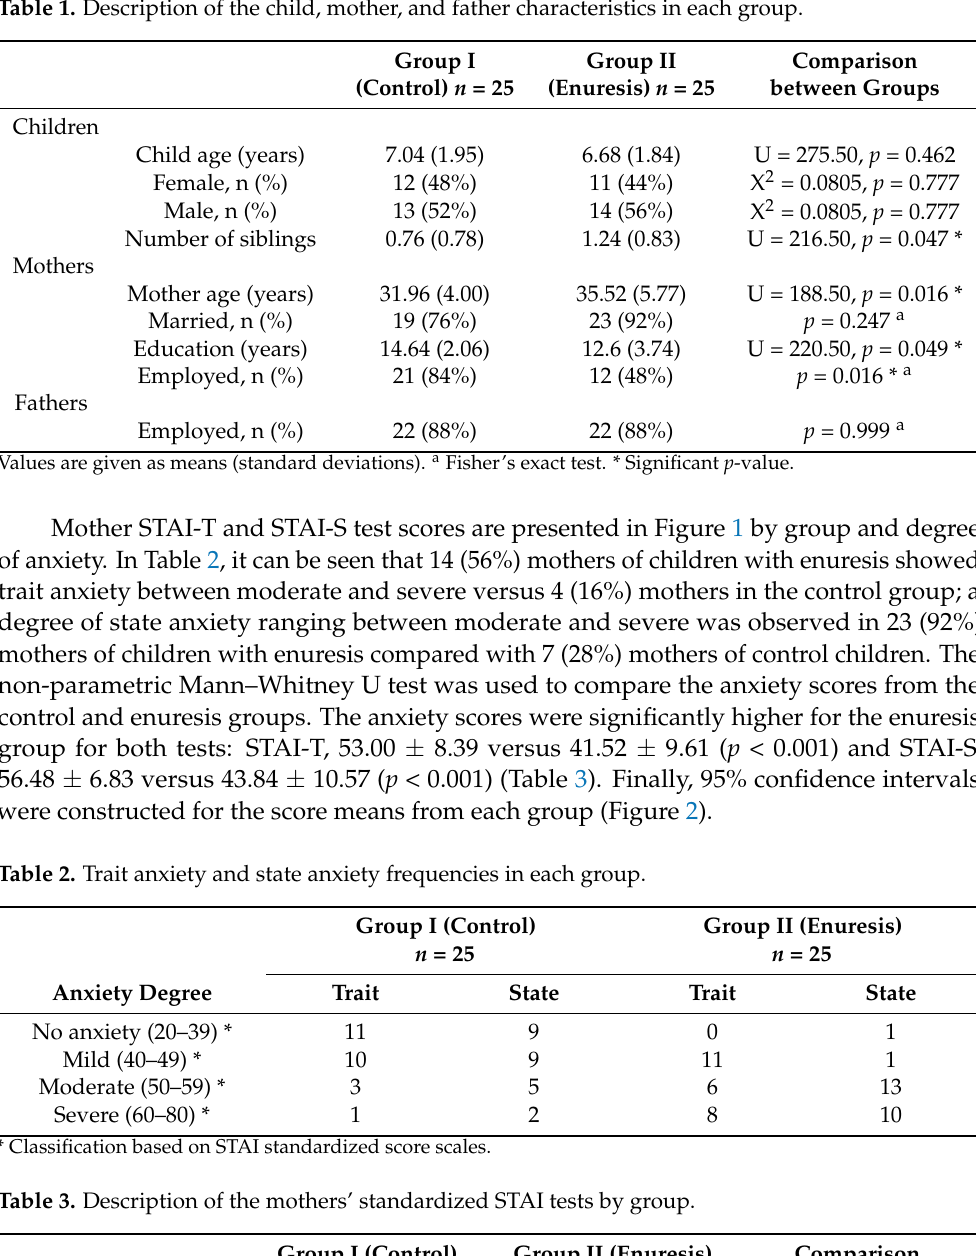
Table 1. Description of the child, mother, and father characteristics in each group.